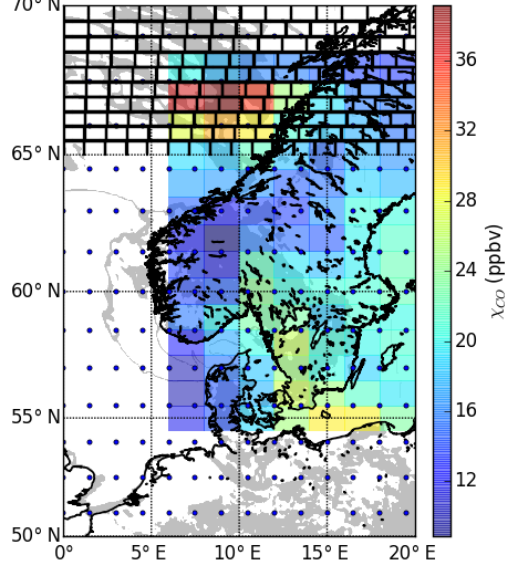
Figure 2. Illustration of the horizontal colocation method, showing satellite data corresponding to cloud top pressures below 1000m altitude (gray shading), the average FLEXPART CO concentration between 1 and 2km (colored shading), and the spatial resolution of temperature profiles and specific humidity in blue points. The black grid, at the top of the map, corresponds to the sinusoidal equal-area grid used in this study for colocating each data